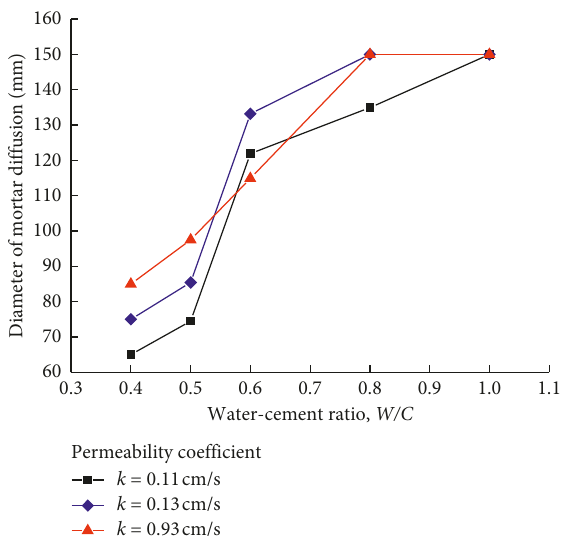
Figure 6: Characteristics of slurry diffusion ( P � 0.2 MPa).